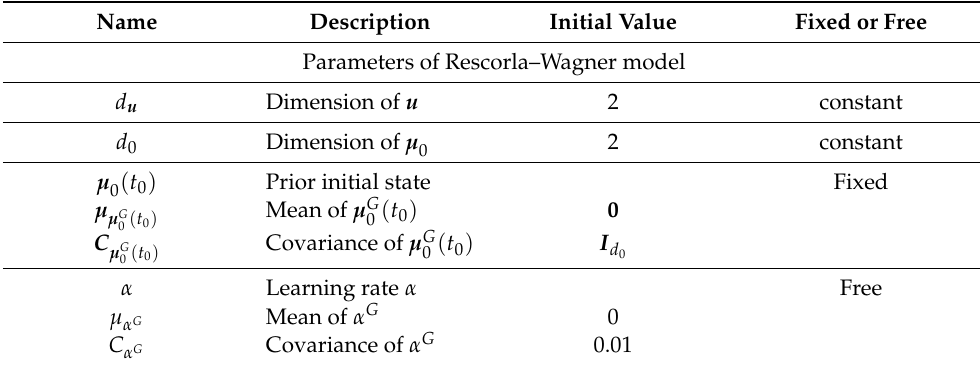
Table A2. Parameters of the Rescorla–Wagner model. Parameters labeled by ‘Free’ are optimized by the inversion of the model. Fixed parameters are constant and not optimized. The notation 0 is a zero vector. Given all initial priors, we search the optimal priors on the free parameters µ the free energy principle (Equations (A19) and